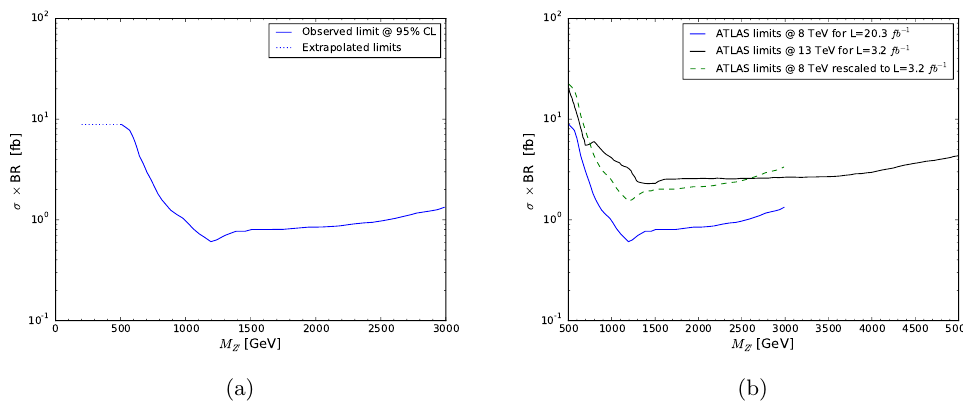
Figure 4 . (Left) Observed exclusion limits on the branching fraction times cross section in the e(cid:22) channel [12]. The limits have been extrapolated down to masses of 200 GeV by applying a constant continuation. (Right) The blue curve shows the exclusion limits on the branching fraction times p cross section at s = 8 TeV given in ref. [12]. The black curve shows the preliminary limit at p s = 13 TeV given in ref. [18]. The green curve depicts the 8 TeV limit rescaled to the 13 TeV luminosity. The order of magnitude agreement between this curve and the 13 TeV limit in this region indicate that our luminosity rescaling is